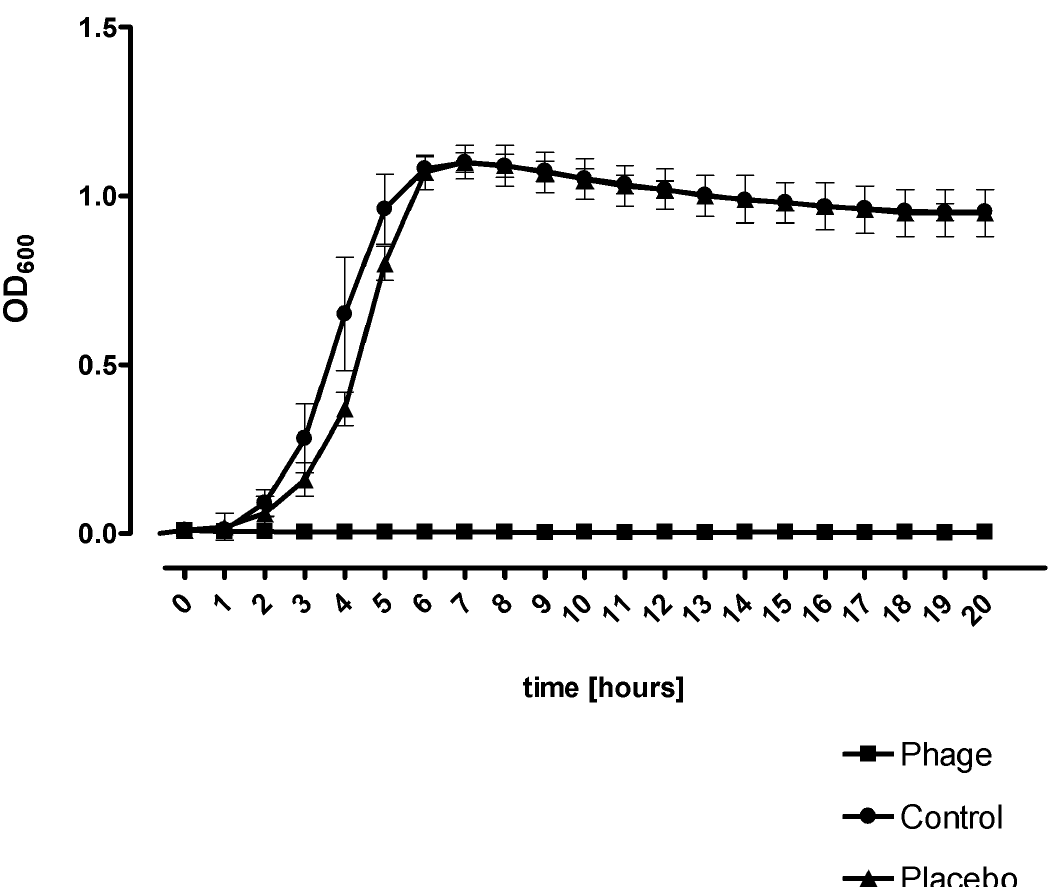
Fig 1. Effect of bacteriophage solution on the growth of MRSA V0608892/1. OD values reflect bacterial concentration in presence of the bacteriophage solution, placebo and no-treated control. The results are presented as the mean OD ± standard deviation of 3 different experiments in